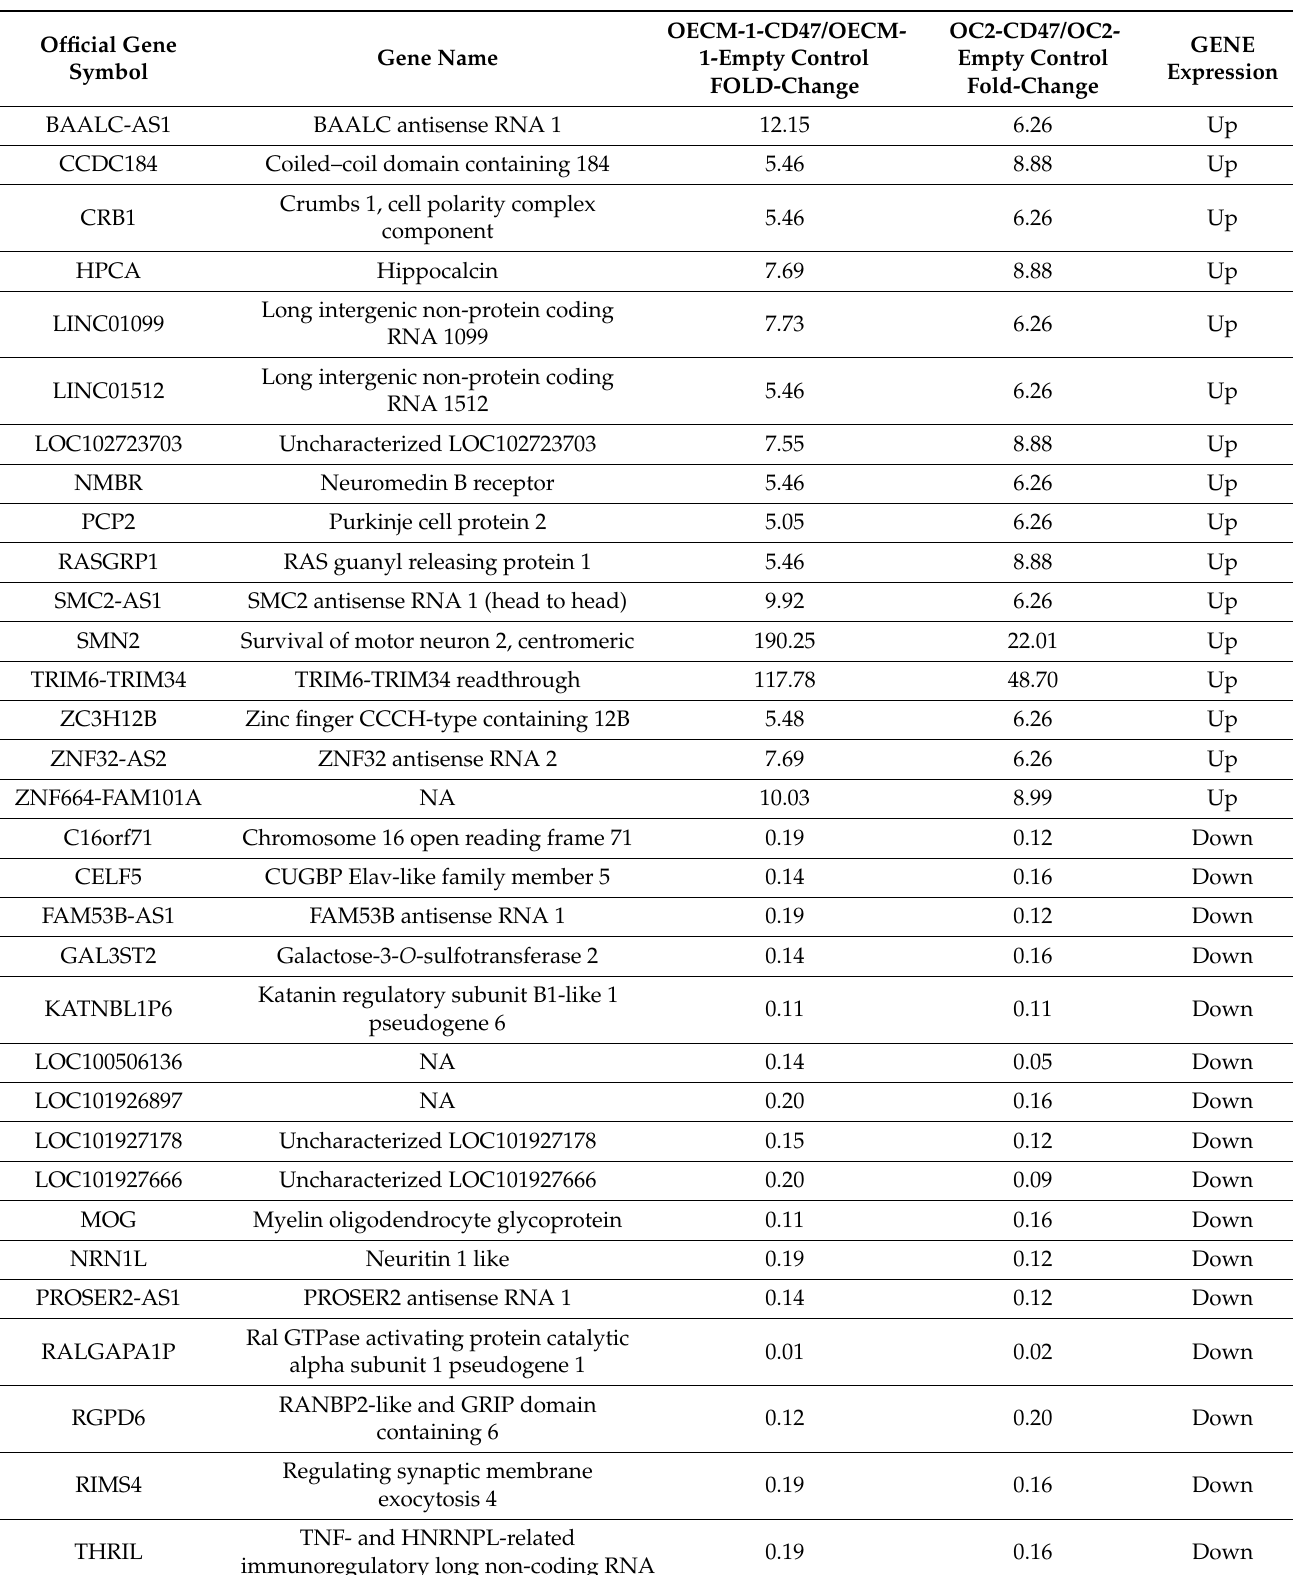
Table 1. Genes with significant changes induced by the overexpression of CD47 in OECM-1 and OC-2 cell